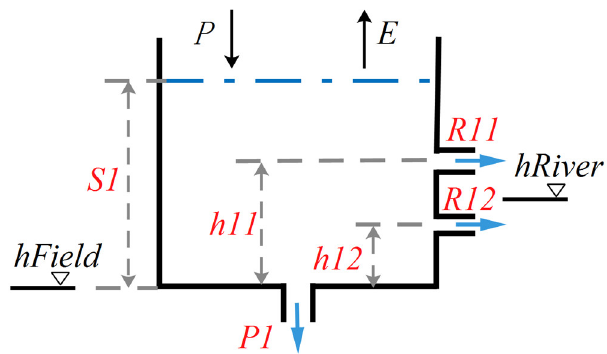
Figure 5. Schematic diagram of the first layer tank.